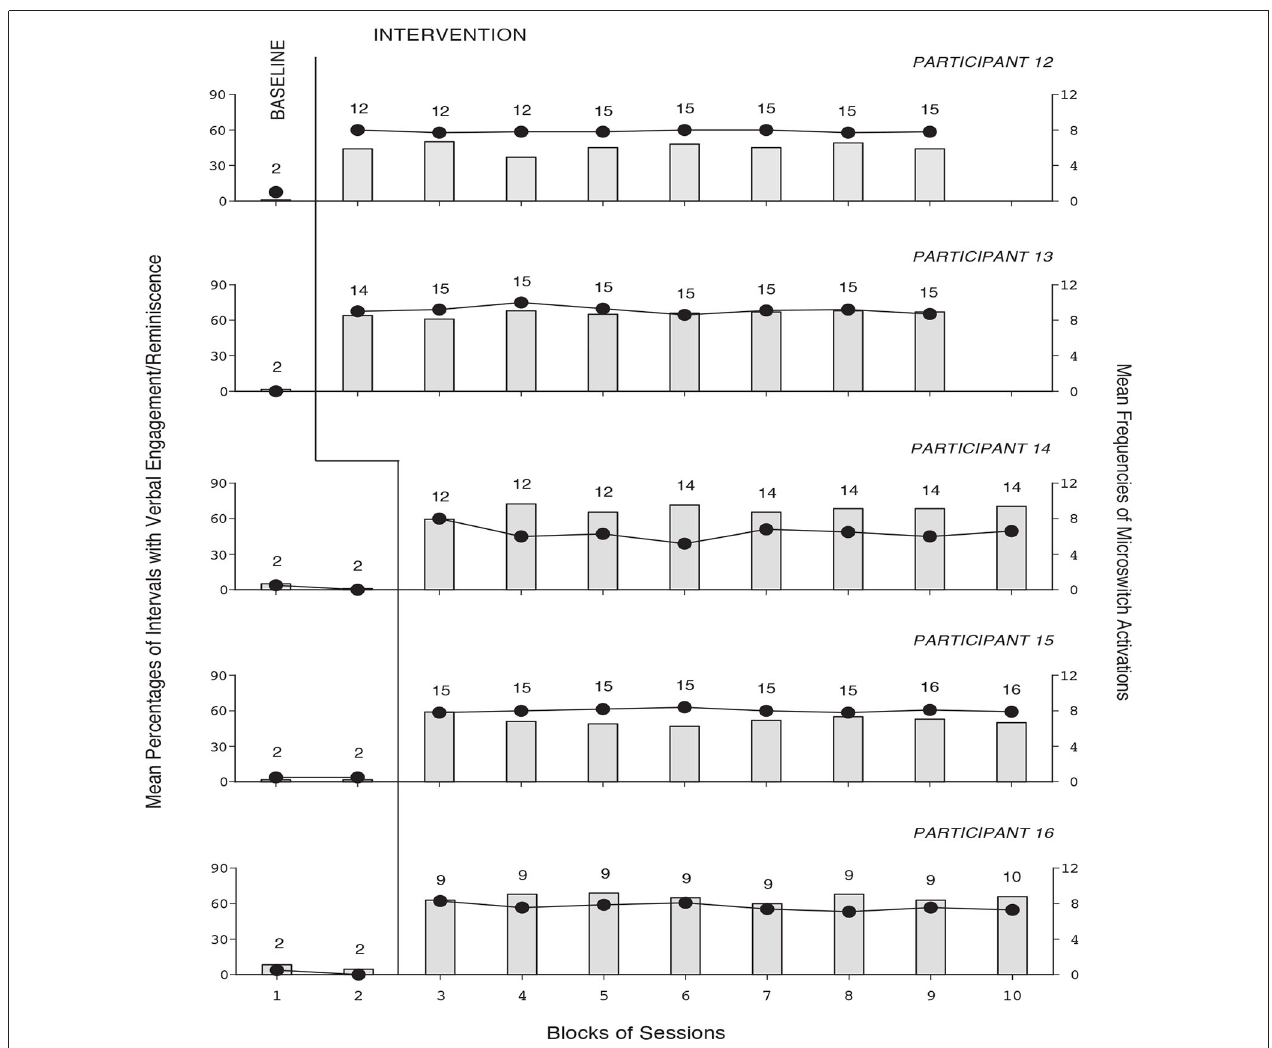
FIGURE 4 | The five panels report the data for Participants 12–16, respectively . Data are plotted as in Figure 1